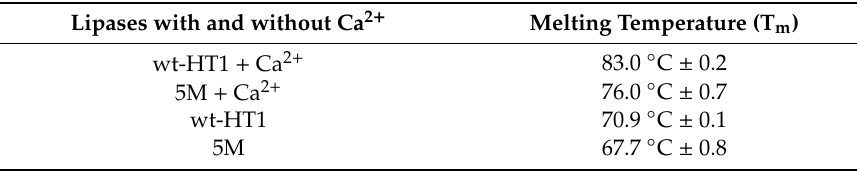
Table 3. Melting temperature point (T m ) of wt-HT1 and 5M mutant lipases with and without calcium ion using Circular Dichroism.